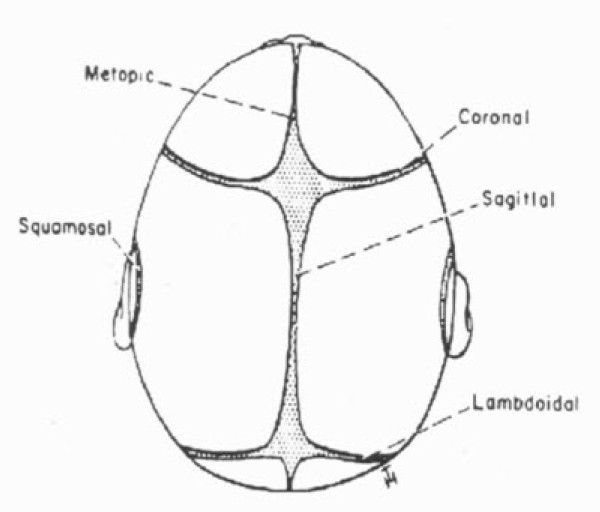
Cranial sutures in infancy. Premature closure of any of the calvarial sutures produces a restriction of growth vectors leading to craniosynostosis.